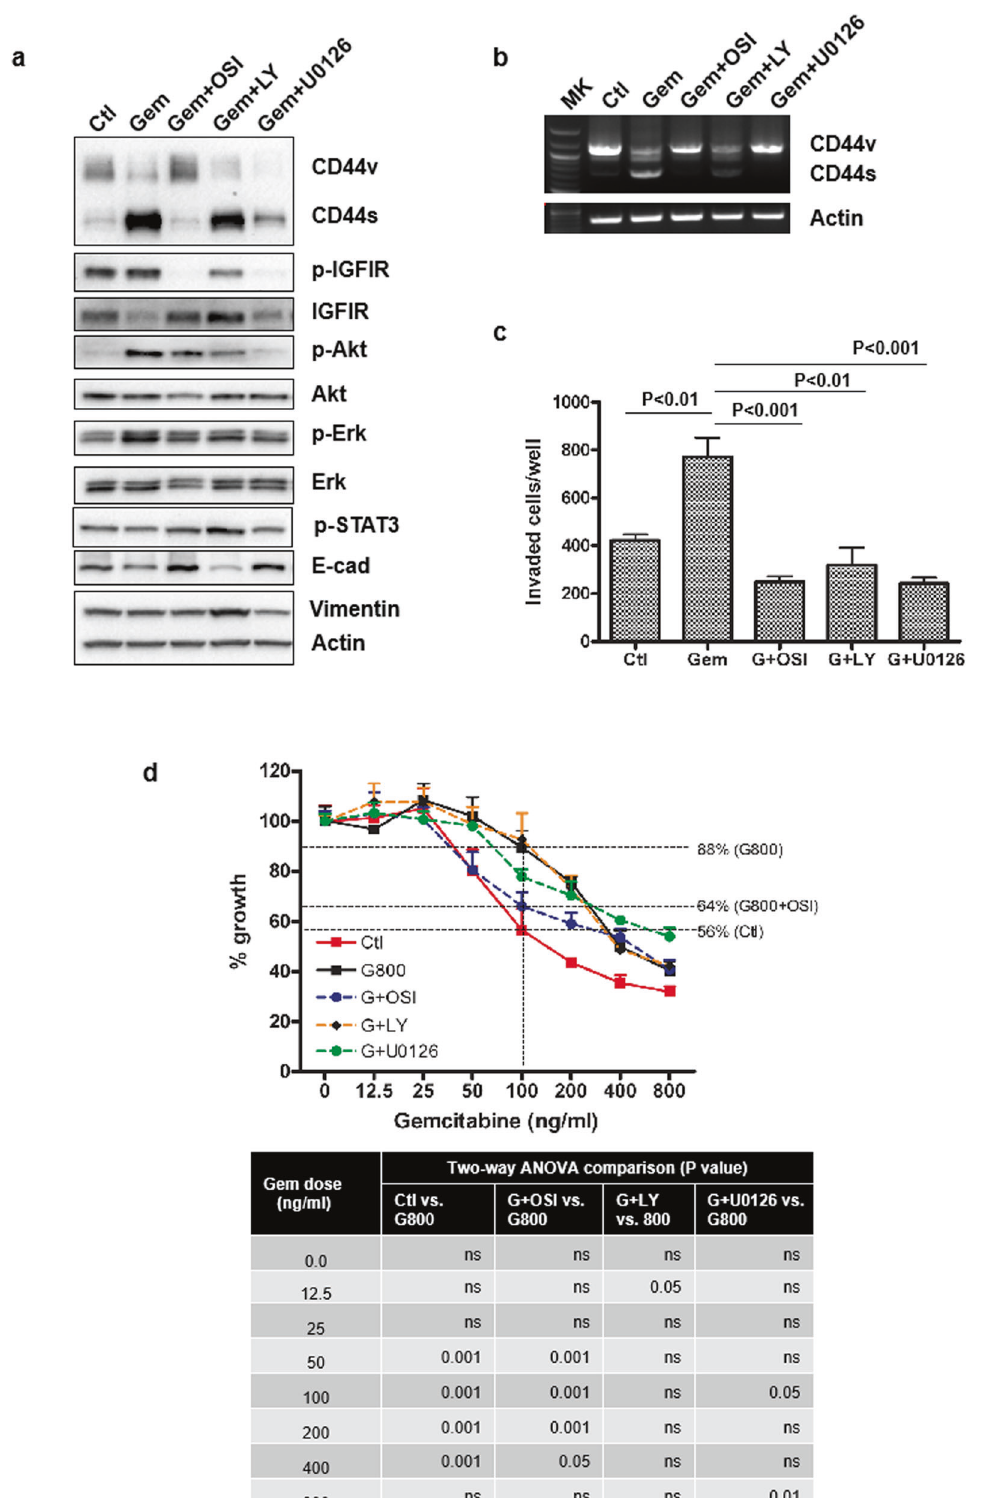
Fig. 6 Blocking IGF1R signaling by pharmacological inhibitors prevents gemcitabine-induced CD44 isoform switching and EMT. a GS cells were treated with the doses of gemcitabine increased weekly (up to 800 ng/ml) and a constant dose of inhibitors (50 nM OSI-906; 10 μ M LY294002; 5 μ M U0126). Cell lysates were analyzed by Western blot with indicated antibodies. b RT-PCR analysis of CD44s and CD44v, primers were same as in Fig. 1c. c Invasion assay performed with the cells from the above treatment (gemcitabine 800 ng/ml). Invaded cells were stained and counted under the light microscope. Data were represented as mean ± SD performed in triplicate. d Cell proliferation rate was performed with the cells that survived from above treatments by MTT assay and the data were represented as mean ± SD in four replicates. The percentage of cell growth for each treatment compared to control at 100 ng/ml gemcitabine is presented. Statistical analysis by two-way ANOVA was shown in the table. Cell Death and Disease (2022)